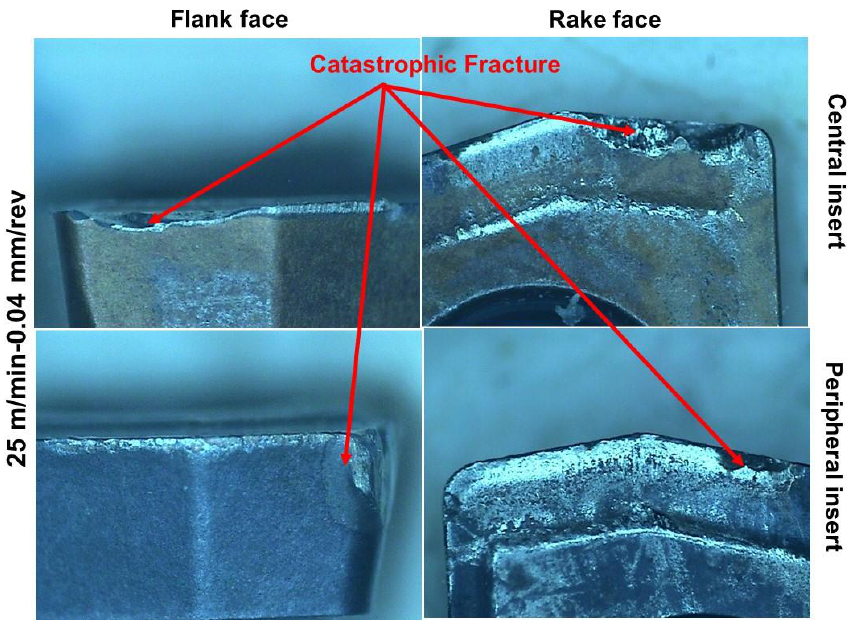
Figure 4. Catastrophic fracture of the inserts after drilling one hole without cutting fluid at Vc = 25 m/min and f = 0.04 mm/rev.